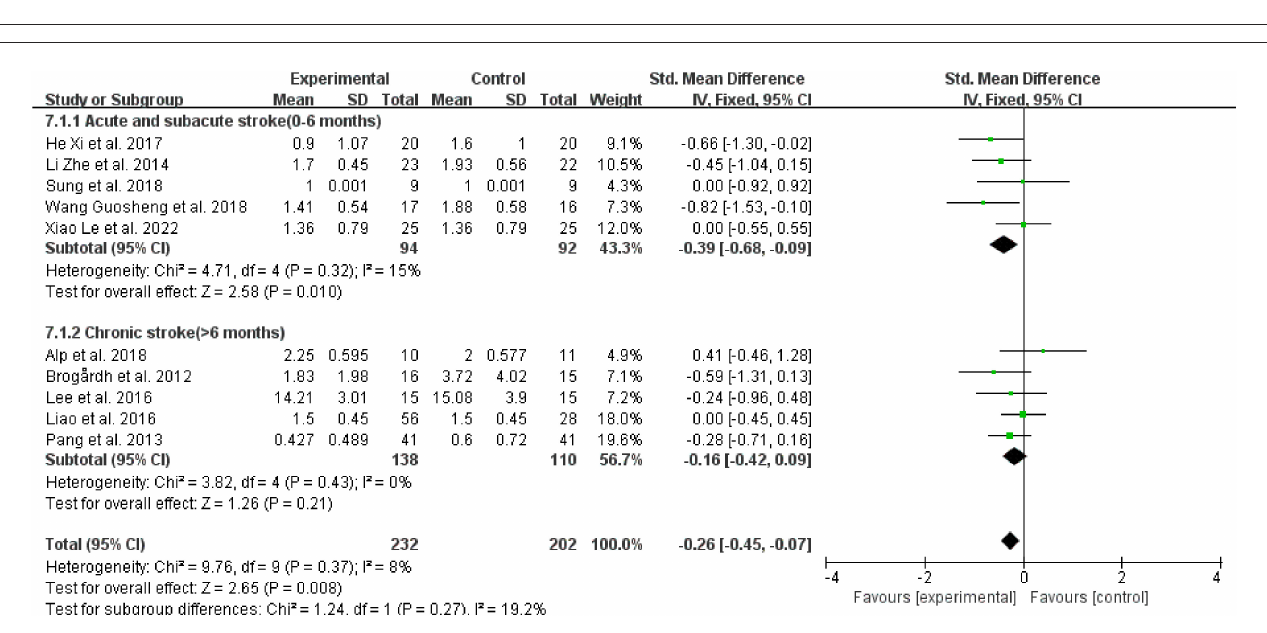
FIGURE6 Forest plot analysis of the efficacy of WBV in subgroups divided on the course of a stroke.